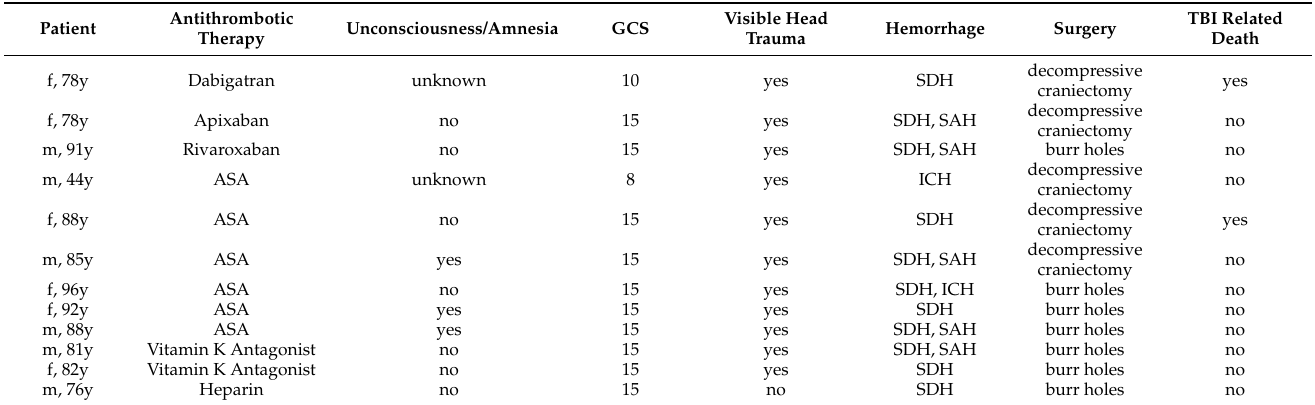
Table 4. Details of patients who underwent head trauma related surgery including history of unconsciousness or amnesia at presentation, GCS at presentation, visible head trauma such as wounds or hematoma, type of hemorrhage, and type of TBI